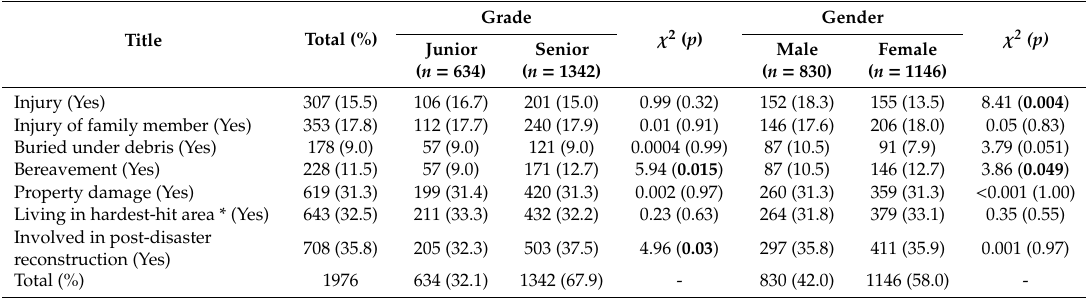
Table 1. Demographic characteristics and traumatic experience among adolescent survivors of the Yushu earthquake, China ( N = 1976).